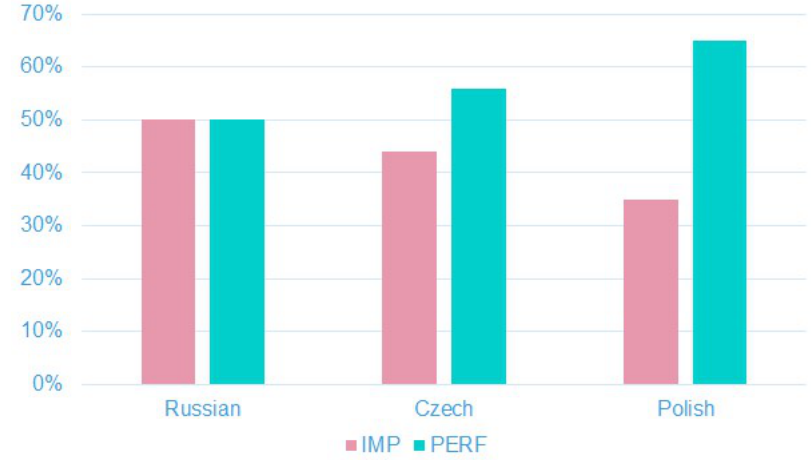
Figure 5. Percentages of aspect choices in factual contexts in Russian, Czech, and Polish.